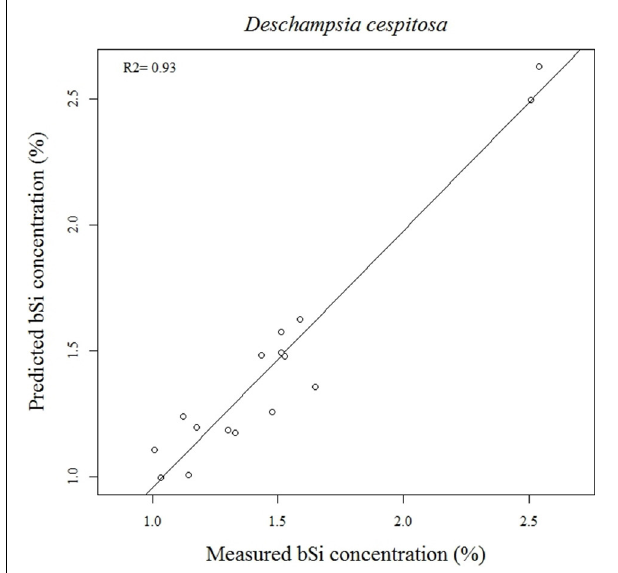
FIGURE 7 | Validation plot of the NIRS calibration model based on samples of Deschampsia cespitosa